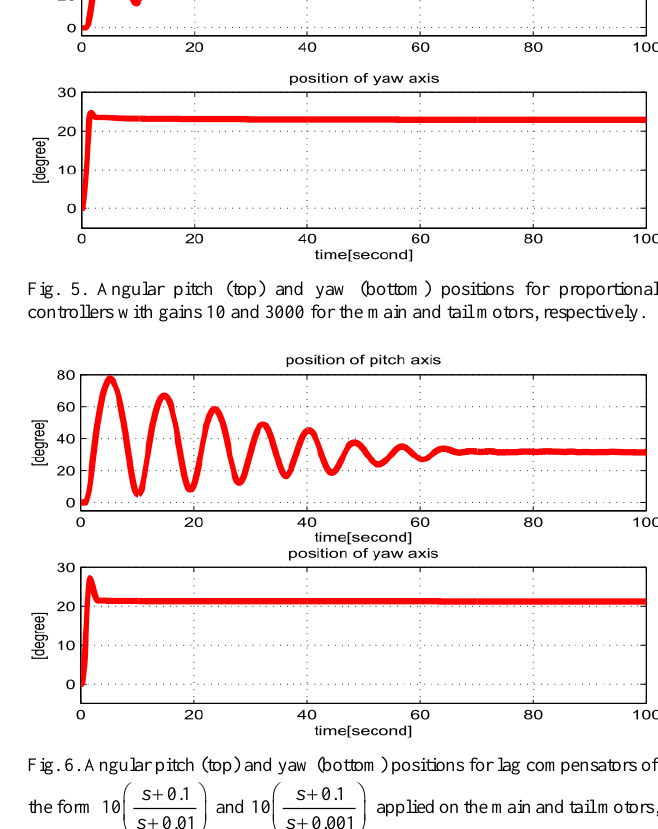
s s +  +  0 . 1 0 . 1 100 100 and applied on the main and tail motors,   s s +  +  . 001 . 01